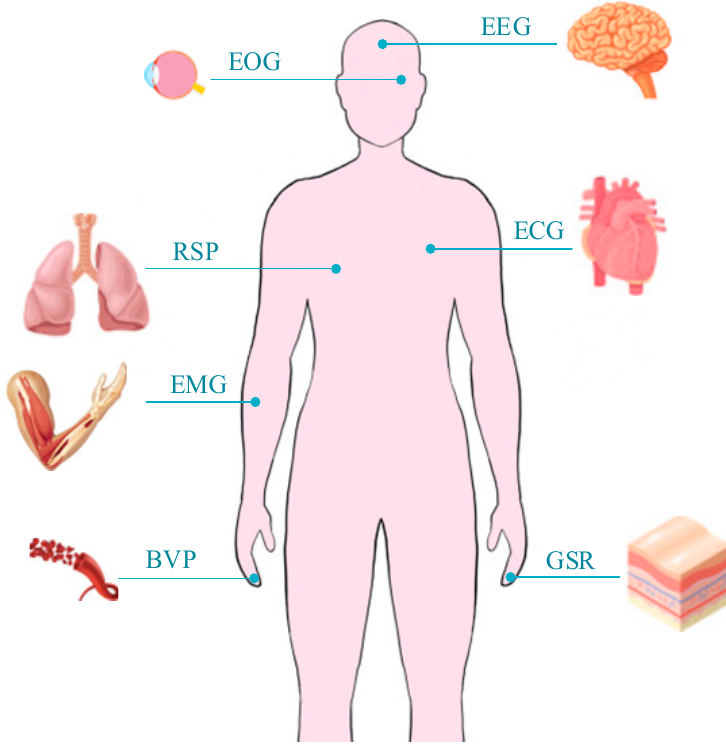
Figure 7. Physiological signals detected by other physiological sensors.